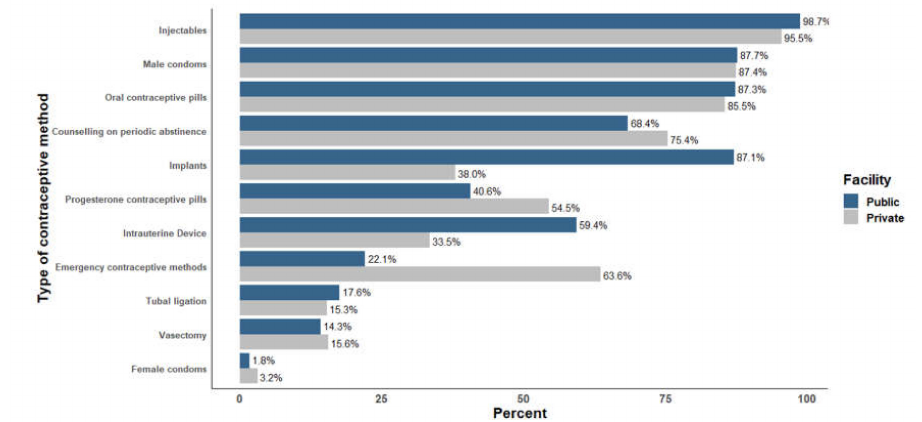
Figure 1. Percentage of public and private PHCU facilities with available contraceptive method, Ethiopian Services Provision Assessment Plus (ESPA + ) 2014.